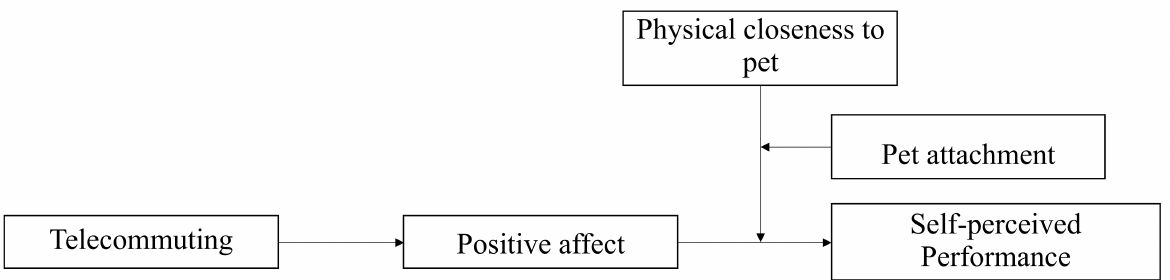
Figure 1. Conceptual model (moderated moderated mediation). H3. The relationship between the attitude toward telework and self-reported job performance, through positive affect, will be moderated by the physical closeness to pets while working, and by the emotional attachment to them, such that the indirect effect becomes stronger when individuals work closer to their pets (versus not working nearby them) and when they show higher levels of emotional attachment to them (versus lower levels) (moderated moderated